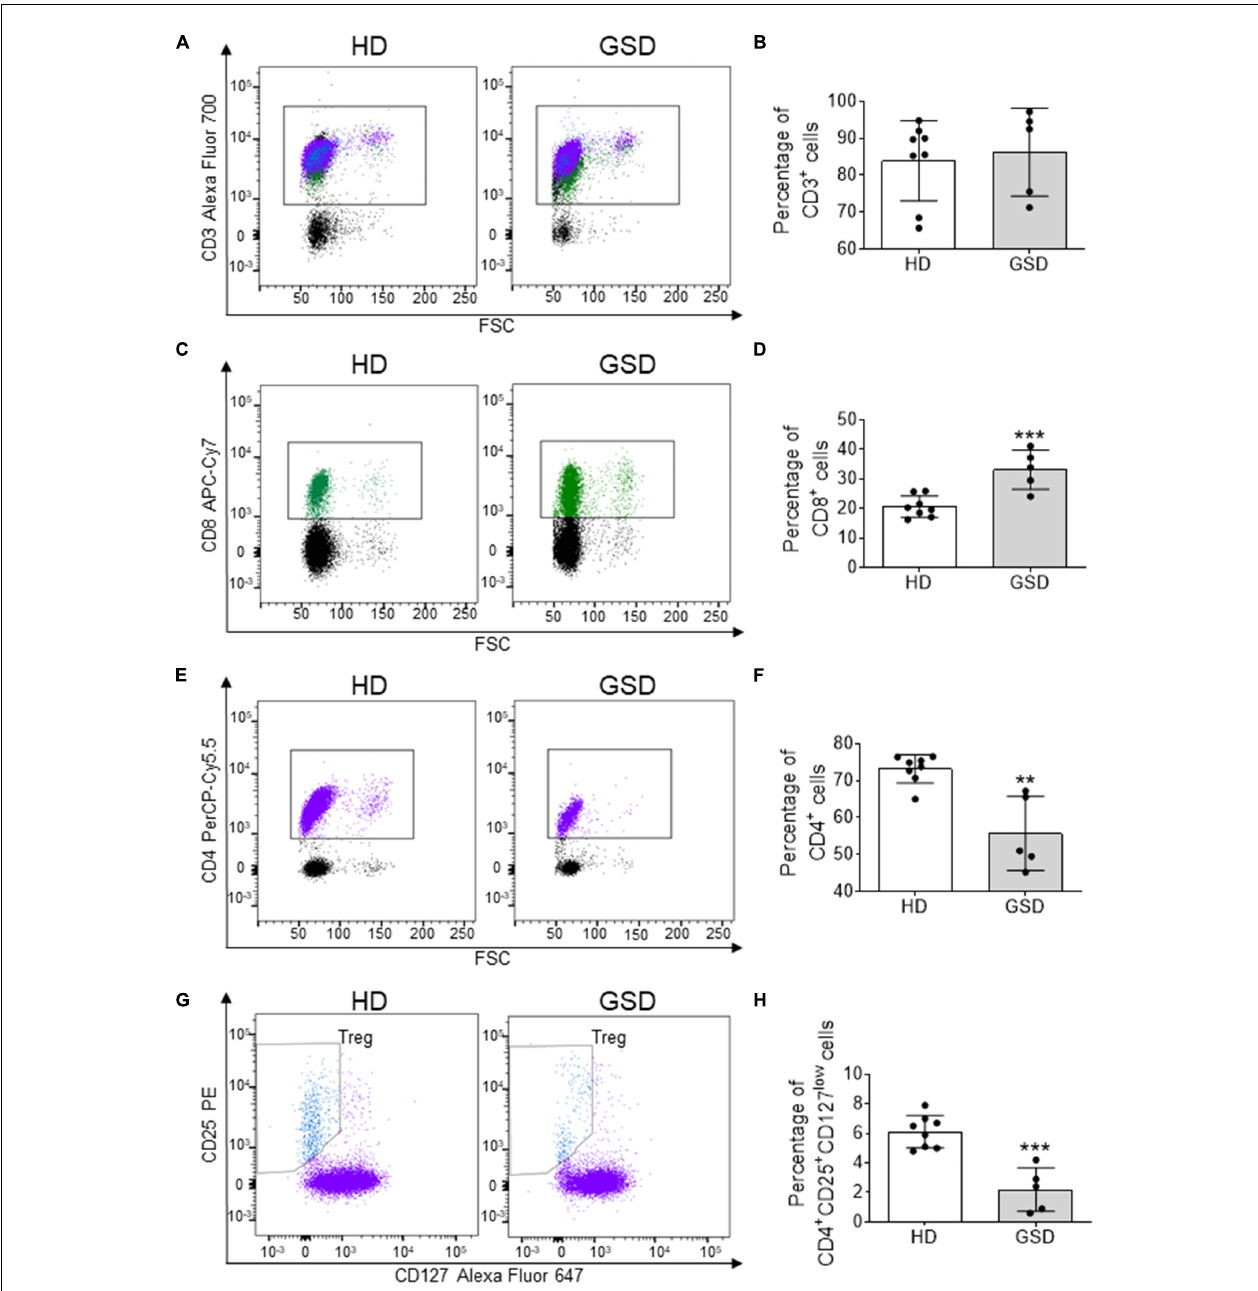
FIGURE 1 | Cytometric analysis performed on PBMC isolated from five patients and eight HD. (A) Representative FACS plot for CD3 + cells; CD8 + cells are in green, while CD4 + and T reg are marked in purple and blue, respectively. (B) Percentage of CD3 + cells. (C) Representative FACS analysis for CD8 + cells in CD3 + gate. (D) Percentage of CD8 + cells in CD3 + gate. (E) Representative FACS plot for CD4 + cells. (F) Percentage of CD4 + cells in CD3 + gate. (G) Representative FACS analysis for CD25 + CD127 low cells in CD4 + gate. (H) Percentage of CD25 + CD127 low Treg in CD4 + gate. Results are expressed as mean ± SD. ** p < 0.01; *** p <